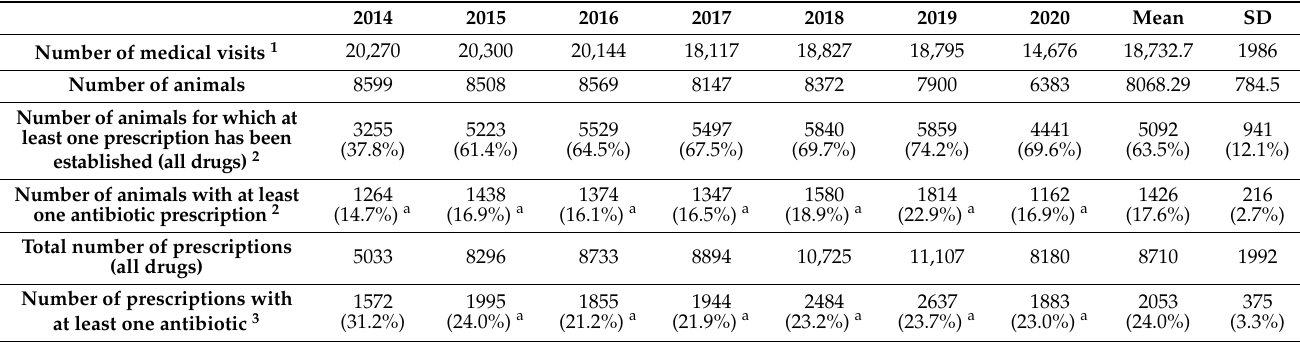
Table 1. General data about medical consultation, caseload, and prescription at the teaching hospital of the Veterinary School of Lyon (France). a Statistically significant frequency variation with 2014 as the reference year ( p < 0.05).